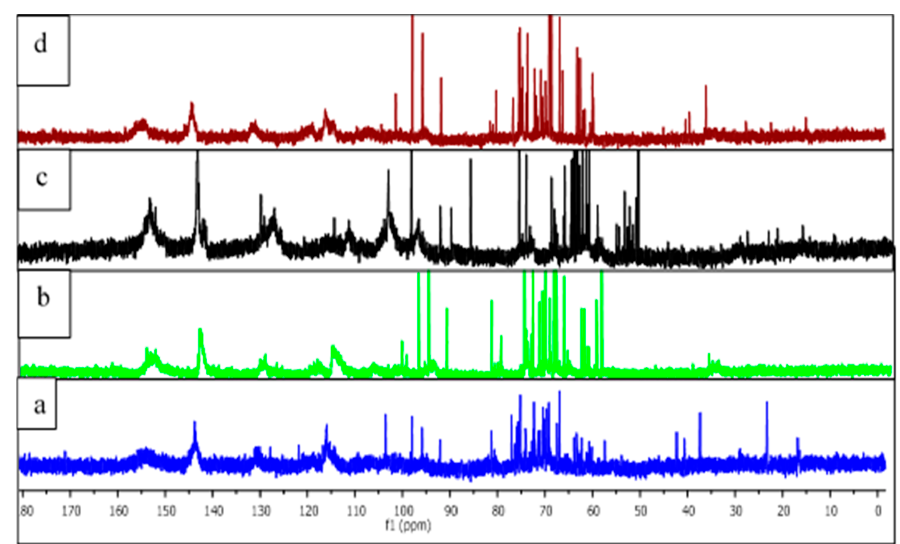
Figure 2. 13 C-NMR spectra of different tannins from Tunisian plants. ( a ) Aleppo pine 70; ( b ) Sumac 70; ( c ) Aleppo pine 100; ( d ) Sumac 100.